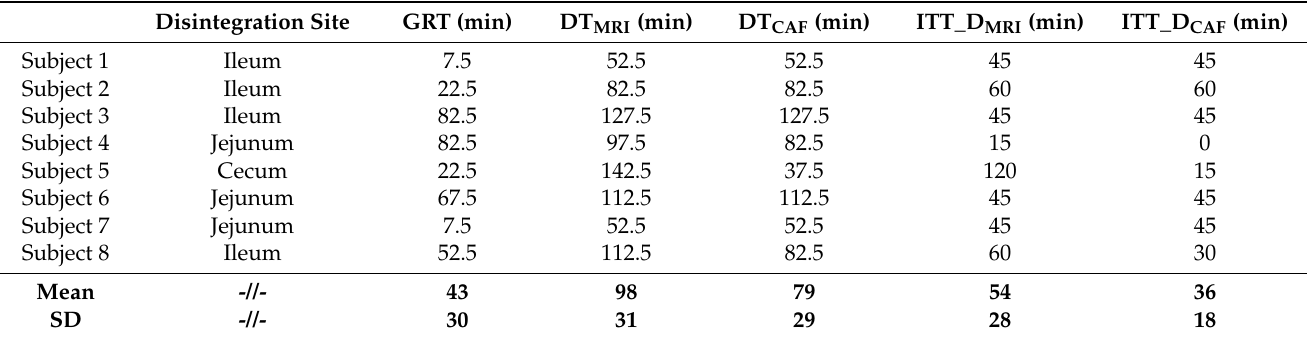
Table 3. Individual disintegration site, GRT, DT, and ITT_D for MRI and caffeine appearance. Mean values ( ± SD) are stated